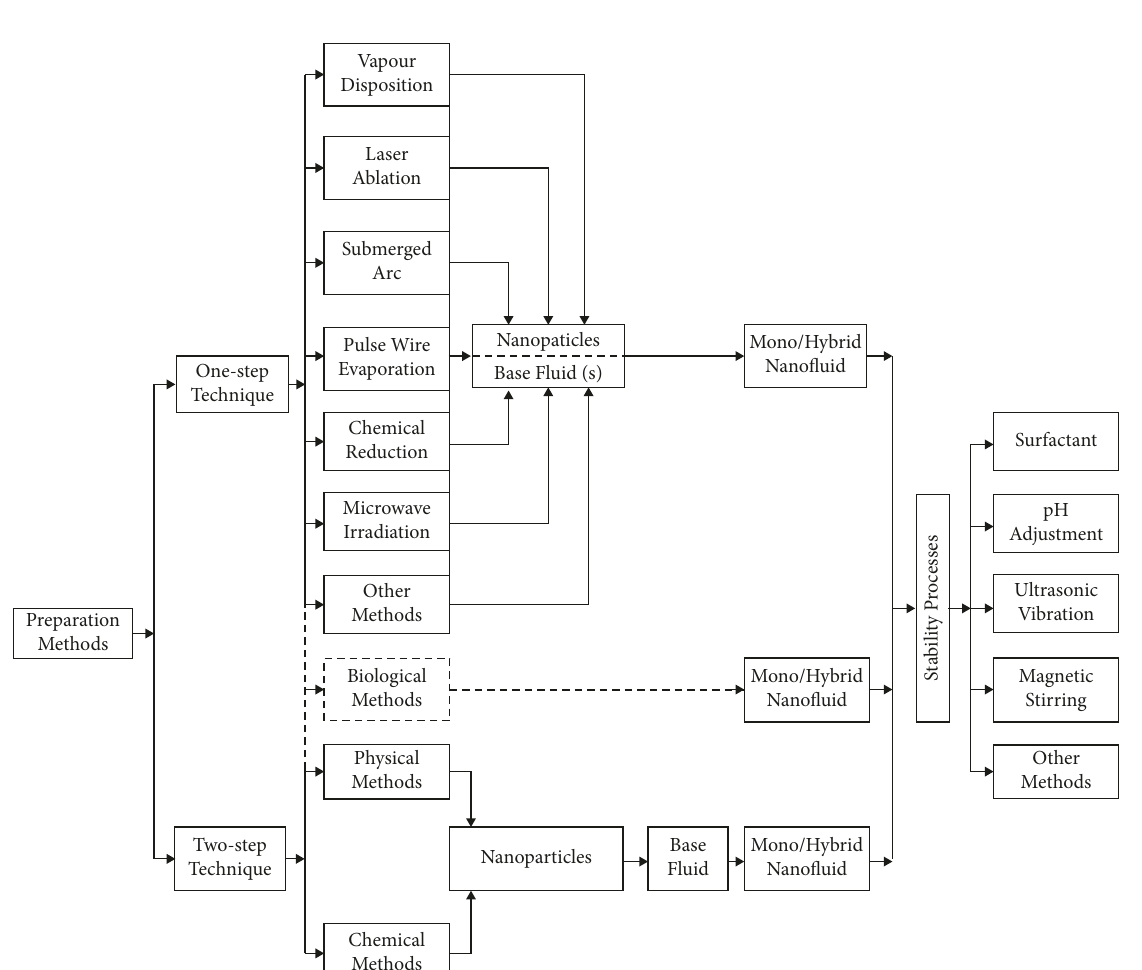
Figure 6: Schematic of various preparation processes of mono and hybrid